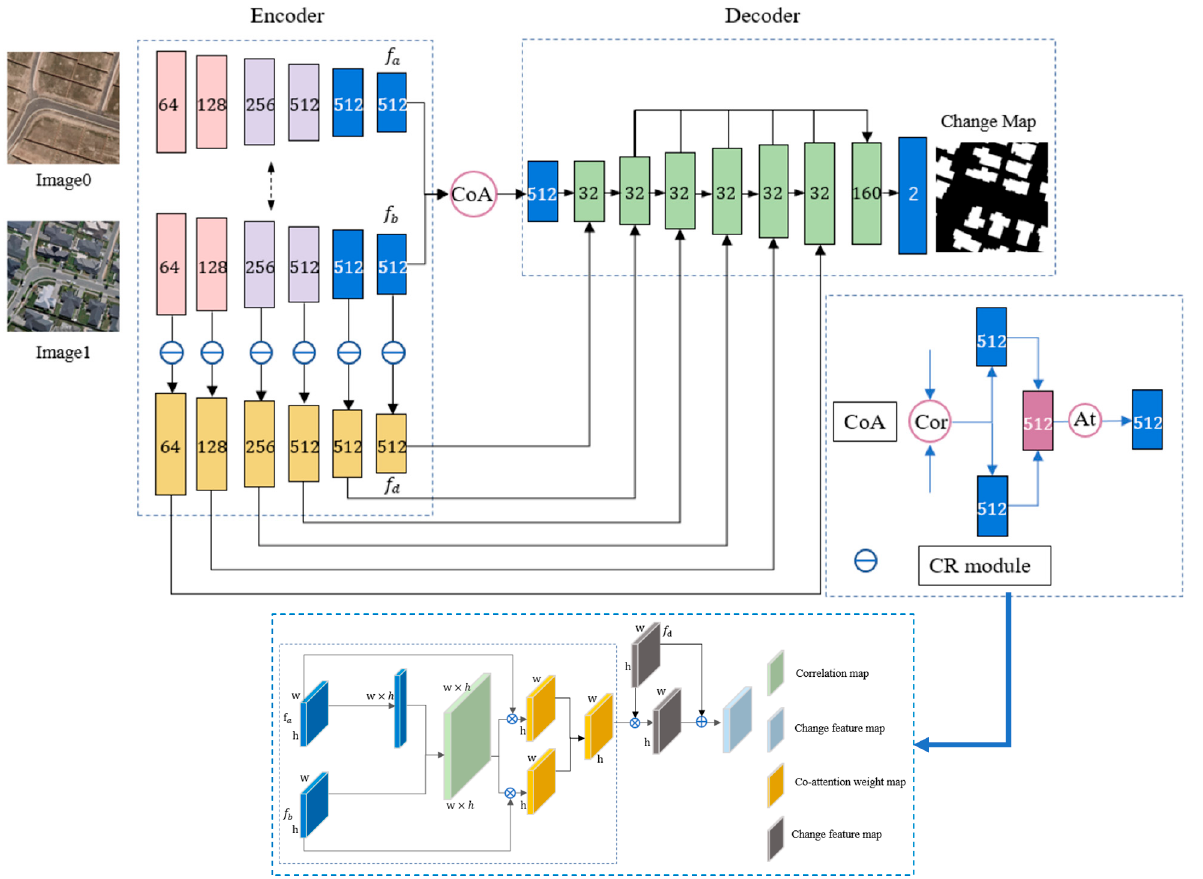
Figure 3. An example of adding attention network (i.e., co-attention) to a CNN module (i.e., Siamese network) for building-based change detection [51]. CoA—co-attention module, At—attention network, CR—change residual module.